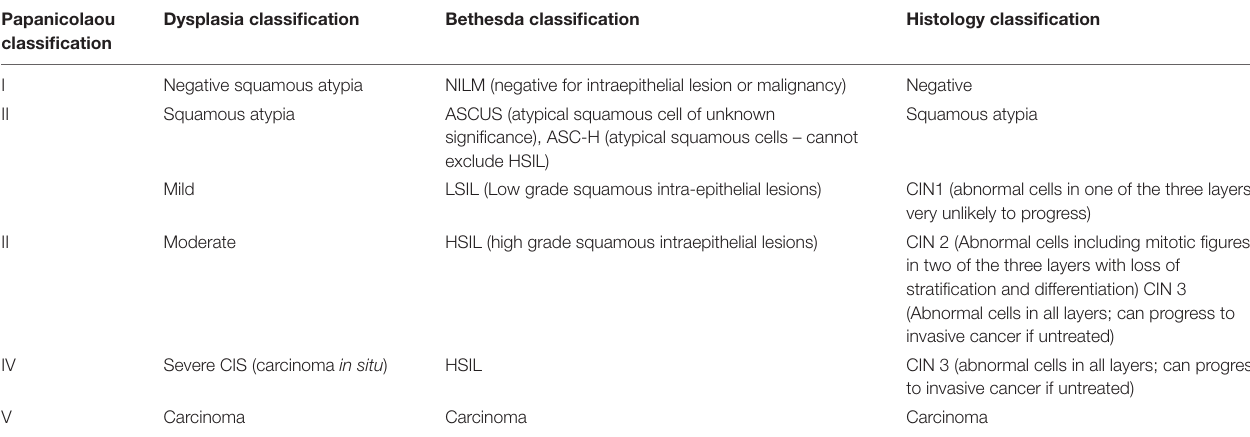
TABLE 1 | Classification of cervical intraepithelial